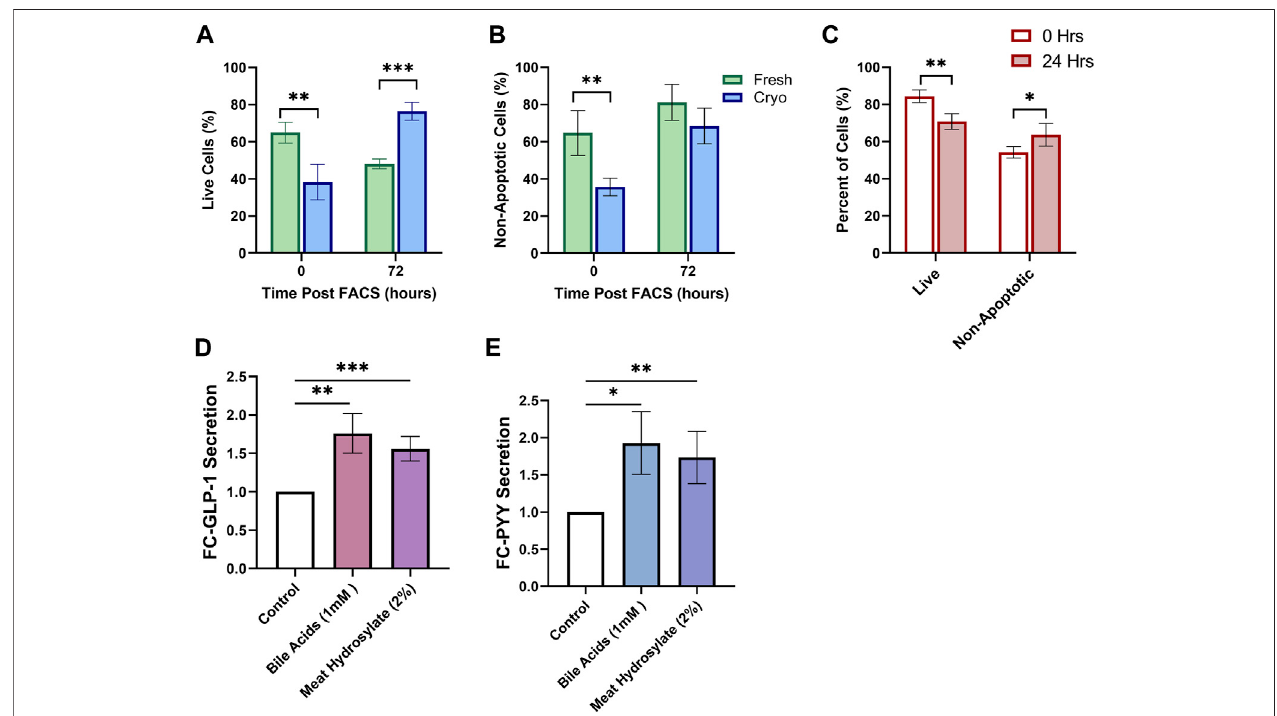
FIGURE 4 | Cryopreserved Human and Mouse FACS-isolated Cells Survive in Short-term Culture. FACS-isolated cells from fresh (green, n = 4) or cryopreserved (blue, n = 4) preparations of mouse colon are analyzed by fl ow cytometry at initial time of sorting and 72 h posting sorting for (A) live cells and (B) non-apoptotic cell proportions after incubation instandardculture conditions. (C) FACS-isolated cellsfrom cryopreserved preparations ofhuman biopsies ( n =4participants)are analyzed by fl owcytometryatinitialtimeofsortingand24 hpostingsortingforlivecellsandnon-apoptoticcellproportionsafterincubationinstandardcultureconditions. (D) GLP-1and (E) PYY secretion from primary intestinal cultures originating from cryopreserved human tissue ( n =5replicates)treatedfor 2 h withPBS-0.5%BSA(control) with or without test compounds: Conjugated Bile Acids (1 mM), meat hydrolysate (2%); data expressed as normalized to protein content, and as fold-change to the control. Signi fi cance testing used a two-tailed student t-test compared between all groupings; * p < 0.05, ** p < 0.01, *** p <